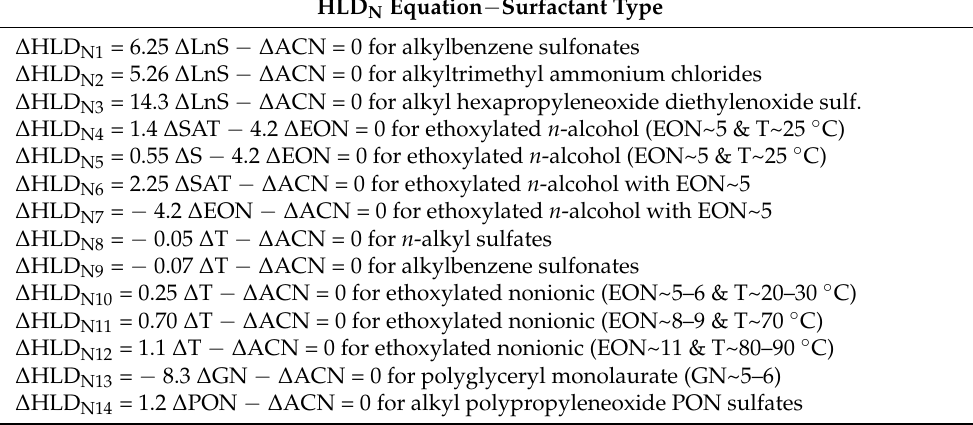
Table 3. Various cases of equations indicating the changes of two formulation variables to deviate from optimum formulation and return to it ( ∆ HLD = 0) with the same − 1 coefficient in front of the ∆ ACN so that all the equations have the same